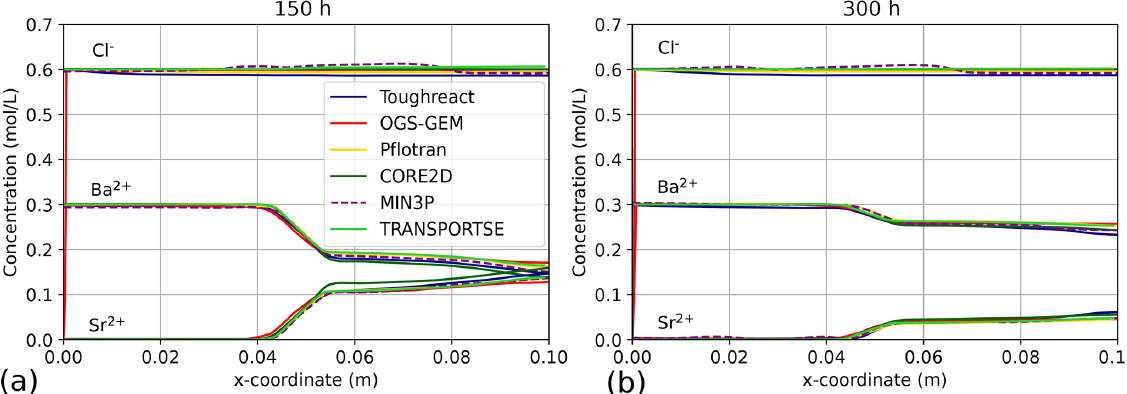
Figure 9. Ion concentrations along Line 1 at simulation times of (a) 150h and (b) 300h calculated by TRANSPORTSE-PHREEQC in comparison against the results documented by Poonoosamy et al. (2021).